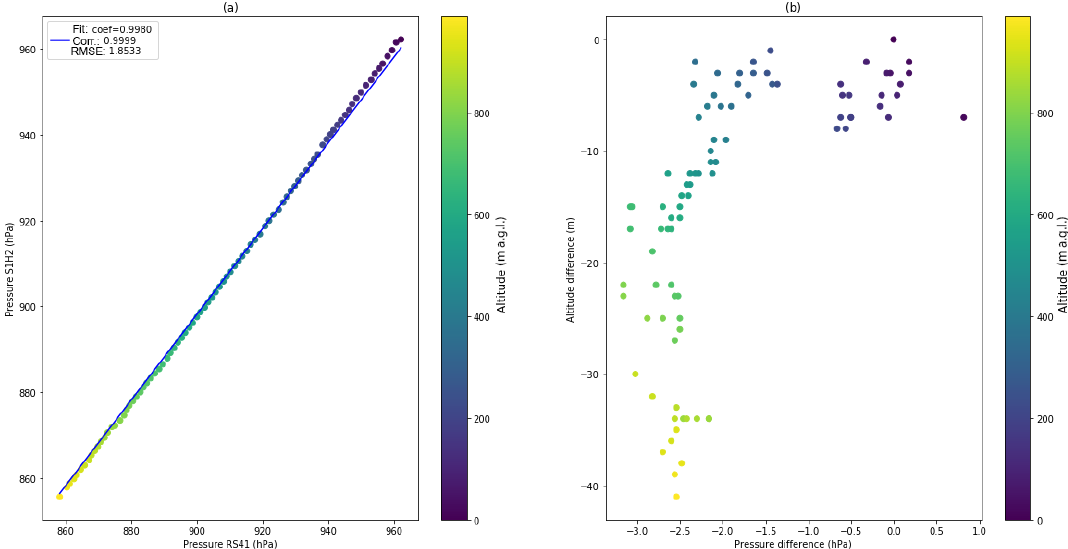
Figure 7. Comparison of pressure recorded by the Windsond S1H2 and calculated by the Vaisala MW41 (a) , the pressure difference between the recorded Windsond S1H2 and the Vaisala MW41, and the altitude difference between the Windsond S1H2 and the Vaisala RS41-SG (b) during the flight of 28 June 2016, 05:44UTC in Kumasi. The colours are based on the Vaisala RS41-SG-measured altitude with the maximum altitude set to